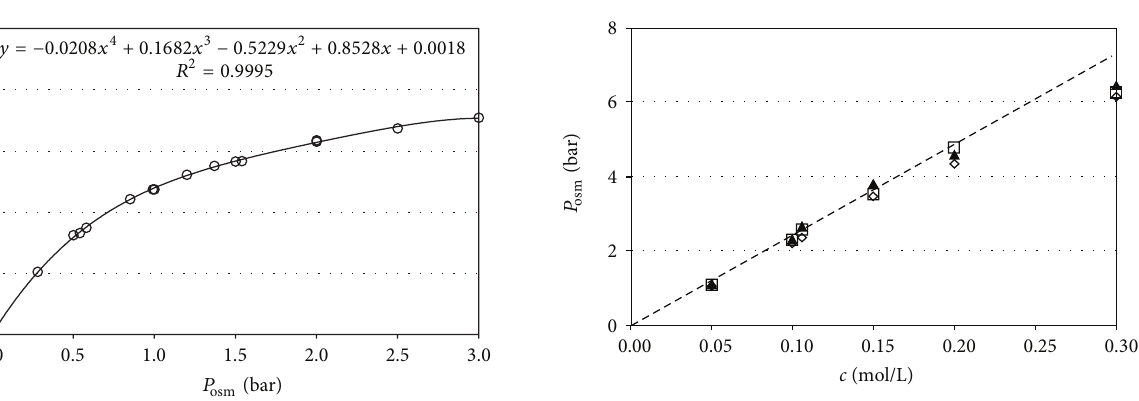
Figure 2: Solvent influx 𝑛 𝐿 [mol] as a function of osmotic pressure 𝑃 [bar] in the regime of variable solution volume. osm